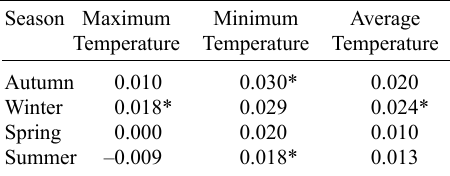
Monthly and average trend of maximum and mini- mum temperatures (°C p.a.) for the period 1960 to